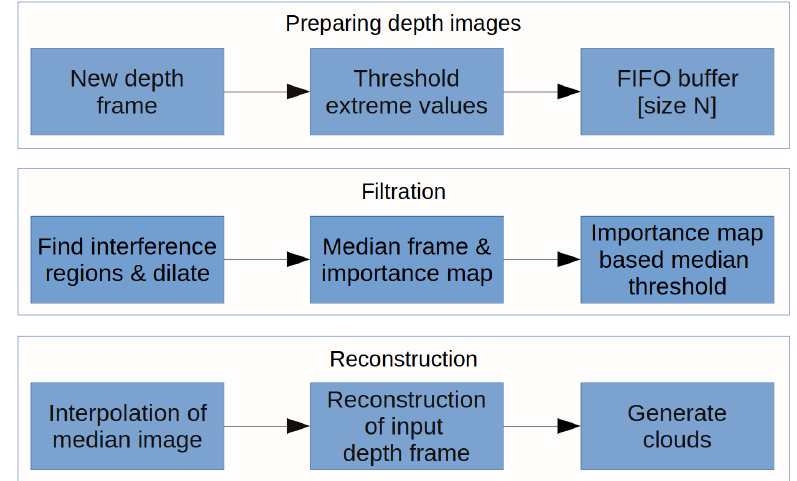
Figure 7. The block diagram of proposed algorithm.